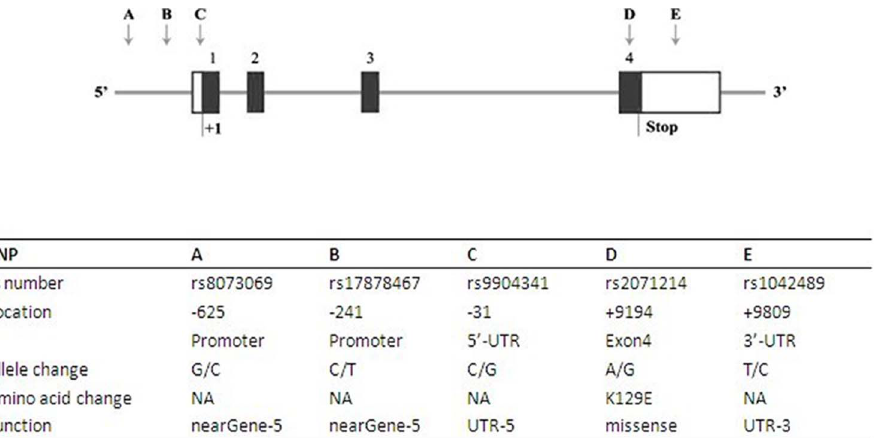
Figure 1. The structure of survivin gene and the features of SNPs in survivin gene that analyzed in this meta-analysis. Exons are shown by the black box and are numbered 1, 2, 3, and 4 from the 5 9 - to 3 9 -end of the gene; introns are shown by the thin line; the untranslated portions of the gene are shown by the white box; the SNPs in survivin gene are shown by the arrow and labeled A to E. The start and stop sites of transcript are shown by ‘‘ + 1’’ and ‘‘Stop’’, respectively.